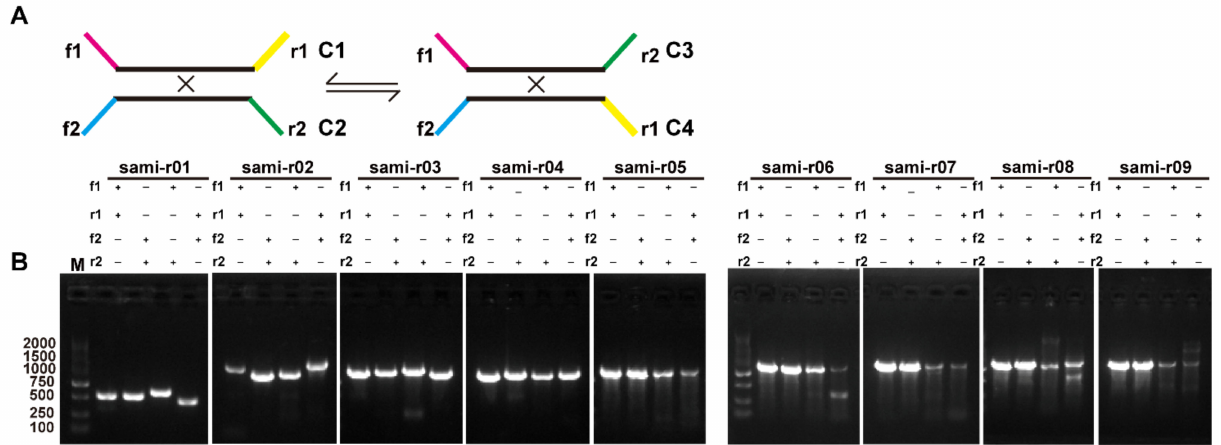
Figure 4. Verification of recombination products associated with the repeats on MC1 and MC2. ( A ) Schematic of the DBSs and their corresponding Mac and alternative conformations. The blank lines represent the two repeat units. The flanking sequences are shown in purple, yellow, green, and blue. The Mac were those observed in our genome assembly. ( B ) PCR amplification of products representing the Mac and Mic conformations. The primer combinations for r01–09 are shown. The Sanger sequencing results of the PCR products are displayed in Figure